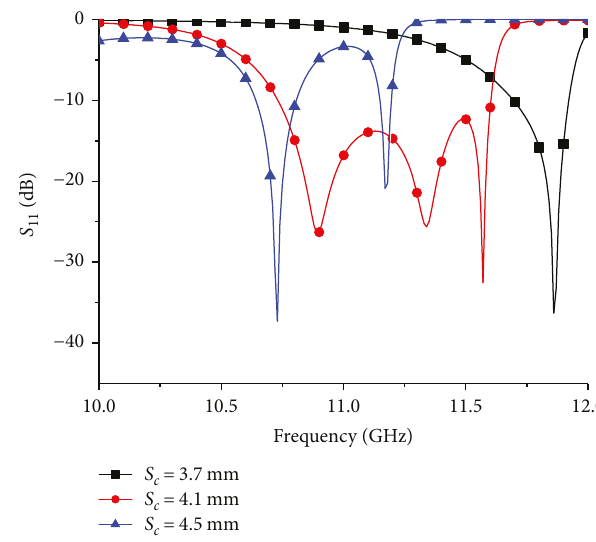
Figure 5: The scattering parameters versus frequency with variable ( W =9.1mm, S =4 mm). W s c c